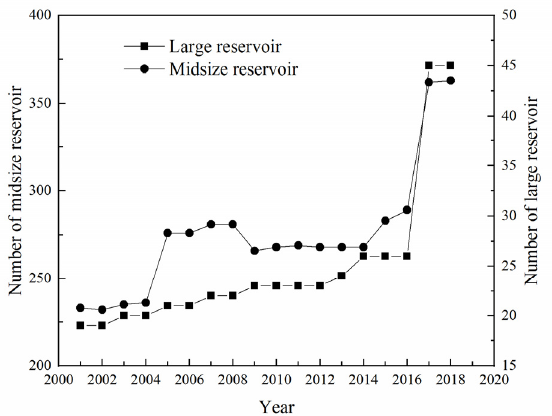
Figure 4. Statistics on the number of midsize and large reservoirs in Hunan province.